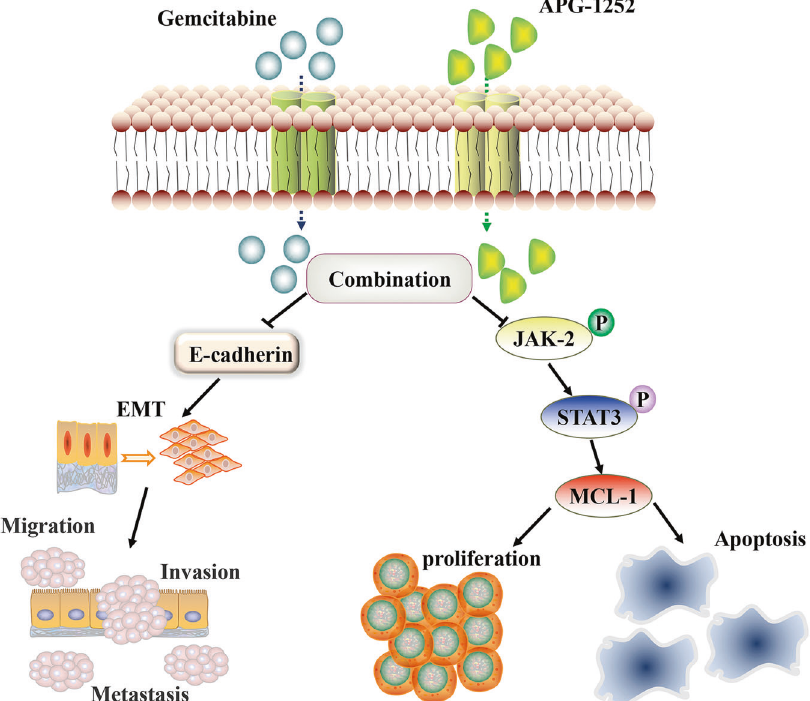
Fig. 7 The inhibitory mechanism of APG-1252 and gemcitabine against nasopharyngeal carcinoma. APG-1252 plus gemcitabine synergistically suppressed NPC by activating caspase-dependent pathways, blocking the phosphor (p)JAK2/STAT3/MCL-1 signaling pathway, and inhibiting EMT